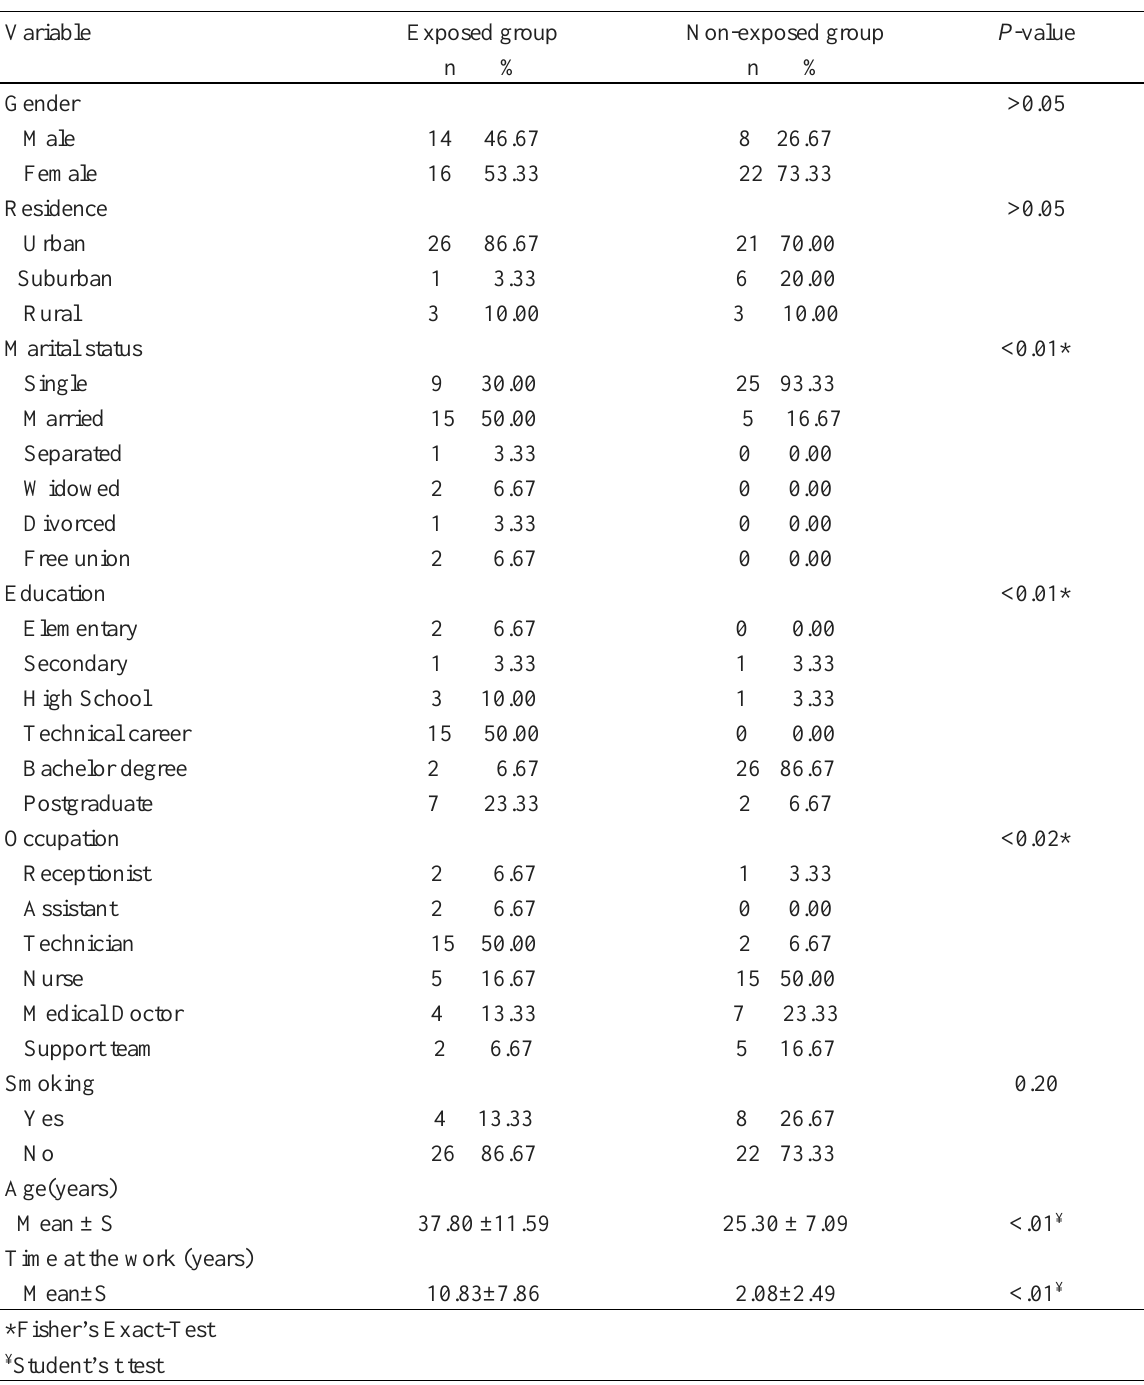
Table 1. Sociodemographic characteristics by